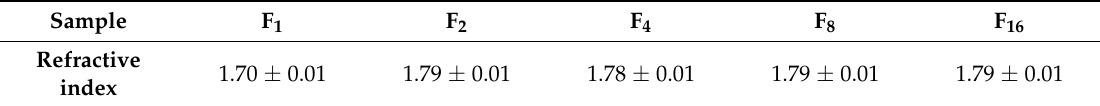
Figure 2. Transmittance spectra of precursor film F 0 , ultraviolet (UV)-irradiated films F x , and quartz glass substrate applied. Air was used as the reference. The lines represent quartz glass substrate ( ━ ), F 0 (—), F 1 (…), F 2 (---), F 4 ( ‒ ‒ ), F 8 (- ⋅ -), and F 16 (- ⋅⋅ -). Table 1. Refractive indices of UV-irradiated films F x .